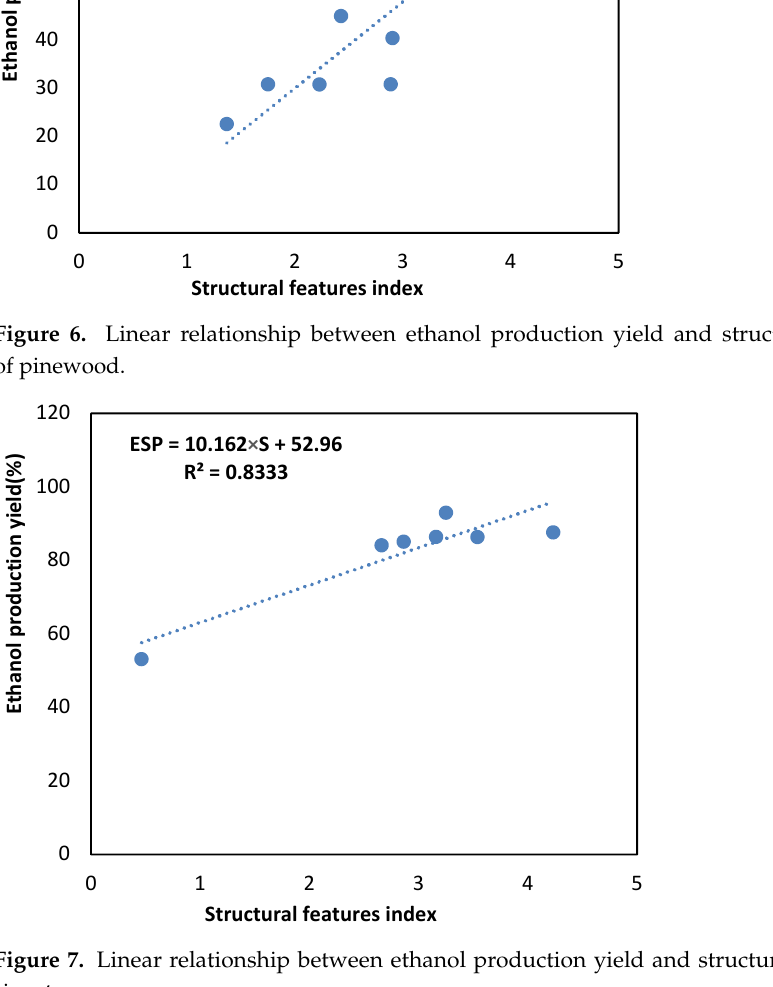
Figure 7. Linear relationship between ethanol production yield and structural features index of rice straw.